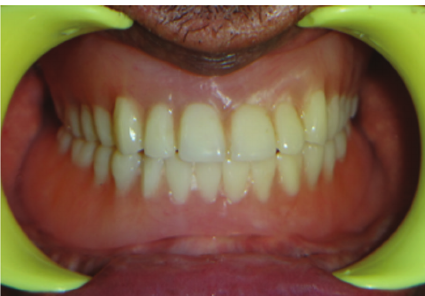
Figure 6: Maxillary and mandibular dentures delivered conventionally.